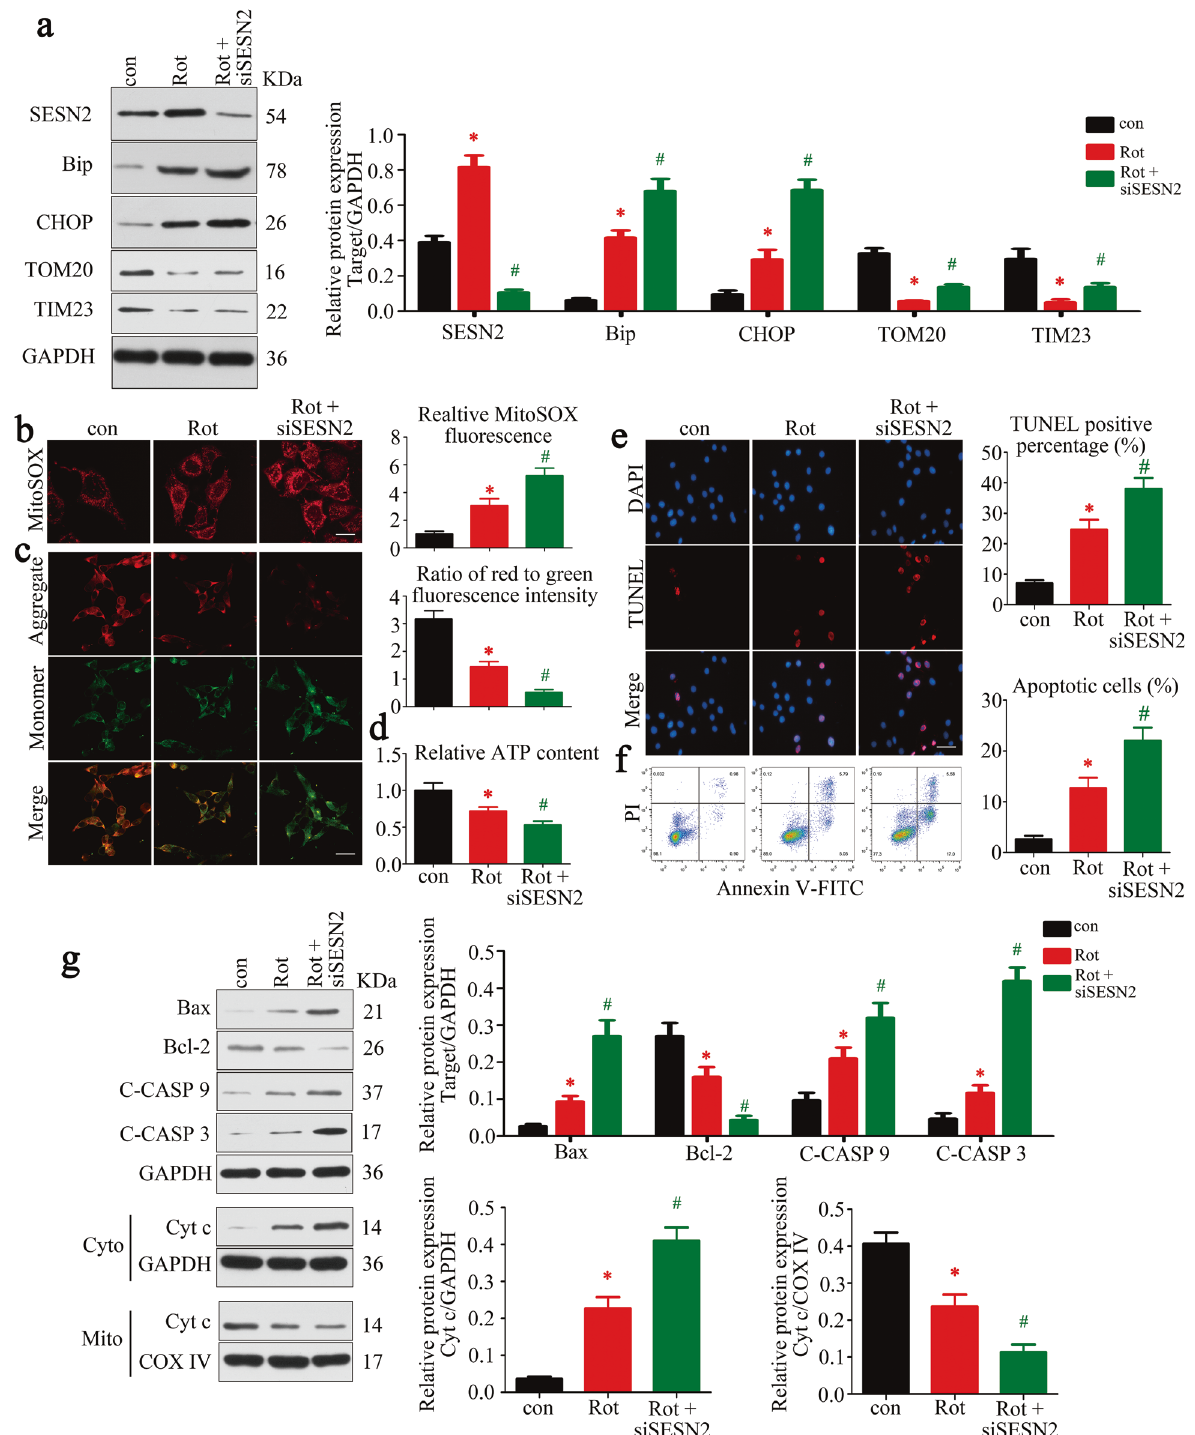
Fig. 4 Knockdown of SESN2 aggravated ERS, mitochondrial dysfunction, and apoptosis induced by rotenone in C2C12 cells. a Western blot analysis examined the effect of siSESN2. ER and mitochondria homeostasis were investigated by Bip, CHOP, TOM20, and TIM23 separately. b MitoSOX Red labeling detected the mtROS levels under different treatment. Scale bar 10 μ m. c Determination of Δψ m using the JC-1 probe. Red and green fl uorescence represented the aggregate and monomeric form of JC-1, respectively. The ratio of red-to-green fl uorescence intensity was calculated. Scale bar 50 μ m. d Relative content of ATP. e, f TUNEL and FCM assay indicated the apoptosis of C2C12 cells in each group. The apoptotic rate was further analyzed. Scale bar 50 μ m. g Western blot analysis of the protein changes related to mitochondria- dependent apoptosis. Cytochrome c in cytosolic and mitochondrial subfractions was assessed respectively. Data were presented as mean ± SD. * P < 0.05 vs control (0 nM rotenone treatment). # P < 0.05 vs rotenone treatment. Con control, Rot rotenone, C-CASP 9 cleaved caspase-9, C-CASP 3 cleaved caspase-3, Cyto cytoplasm, Mito mitochondria, Cyt c cytochrome c.